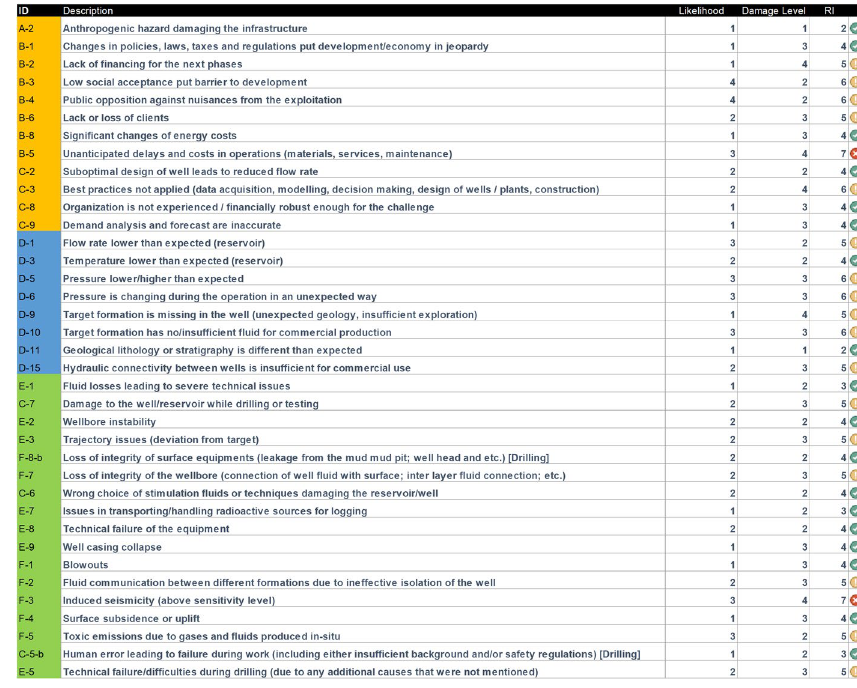
Fig. 8 Risks that were identified and assessed for their likelihood and damage levels for the URG case (yellow: managerial and socio-economic risks, blue: operation and geology risks and green: drilling